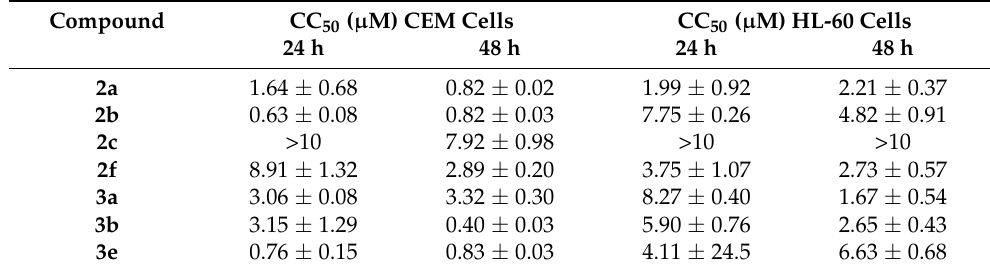
Table 4. Evaluation of 2a – c , f , 3a , b , and e against CEM and HL-60